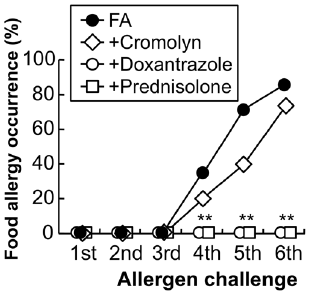
Figure 7. Effect of mast cell stabilizers on the induction of food allergy in mice. The occurrence of allergic diarrhea in FA mice (closed circle) and cromolyn-treated mice (open diamond) after each oral OVA challenge is shown ( n =14–15 mice per group). In addition, mice treated with the subcutaneous administration of doxantrazole (open circle, 10 mg/kg) or the oral administration of prednisolone (open square, 10 mg/kg) did not exhibit any sign of allergic responses in the FA model. ** P , 0.01 vs. FA mice ( n =10 mice per each